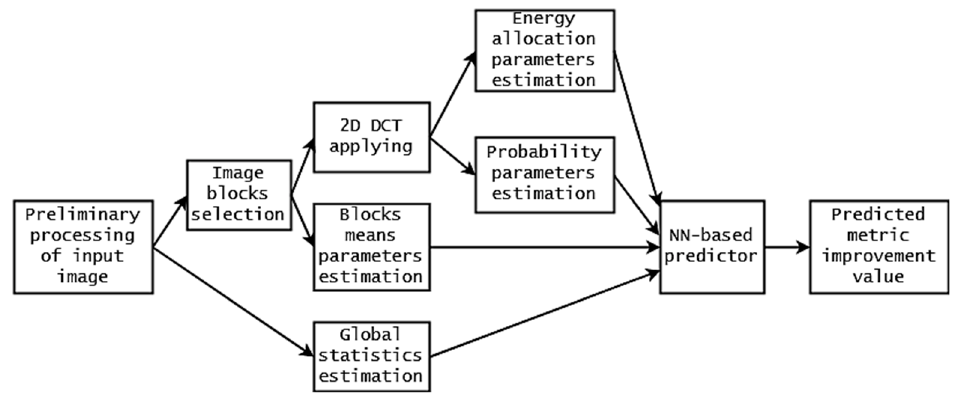
Figure 6. Block diagram of undertaken operations of input parameter estimation. Table 1. Data for different combinations of input parameters for prediction of denoising efficiency for I-PSNR.